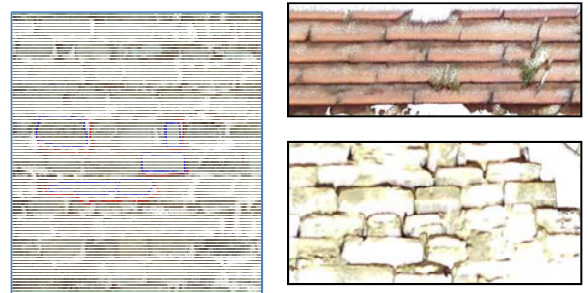
Figure-10 Occurred problems during digitizing of laser scanner